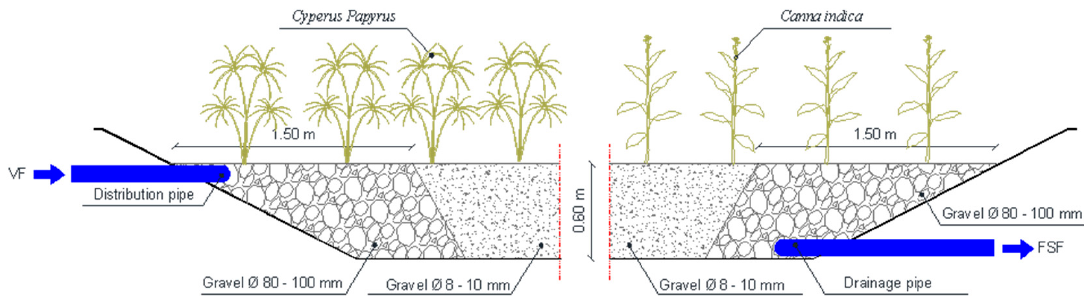
Figure 3. Section of the horizontal subsurface flow bed (HF) located at the Marabino winery.